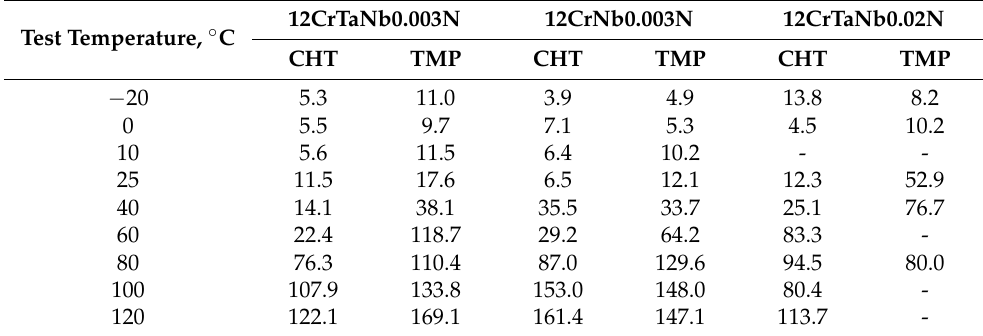
Table 3. Crack propagation energies E i (in J) for the different 12% Cr steels. Test Temperature, ◦ C